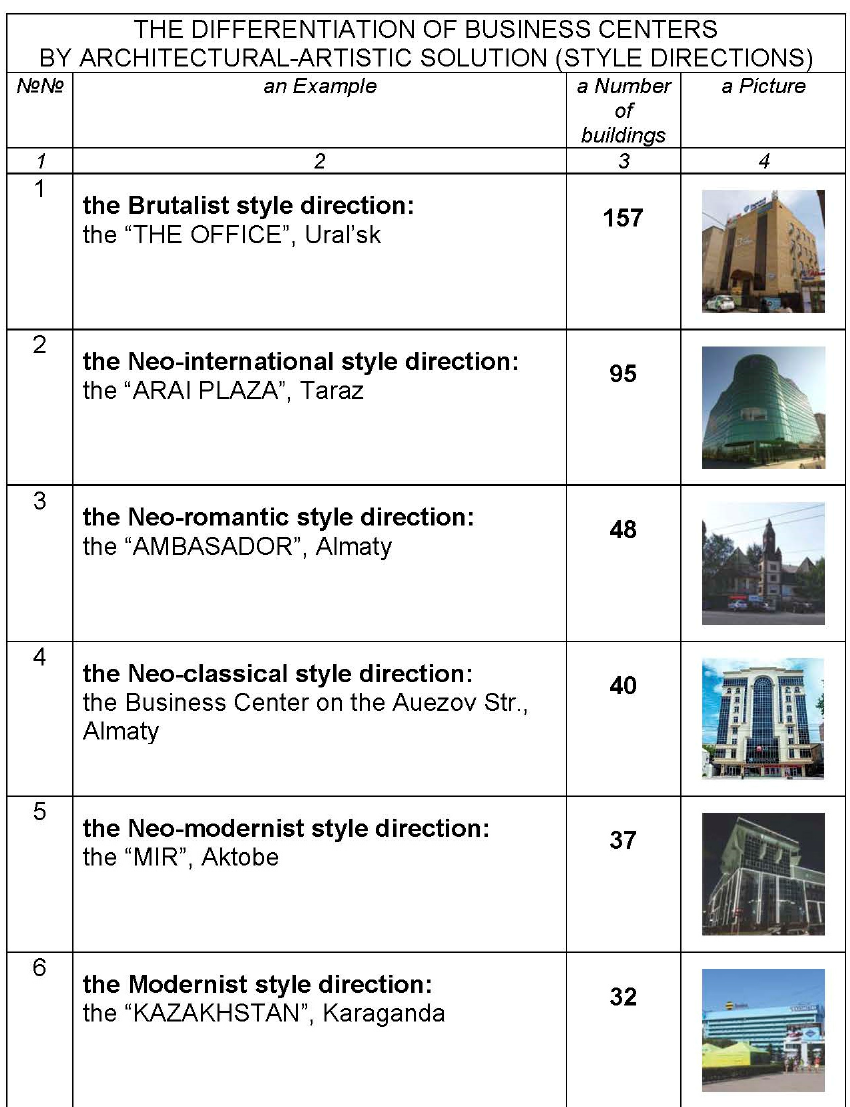
Figure 21. The differentiation of business centers by architectural-artistic solution (style directions):